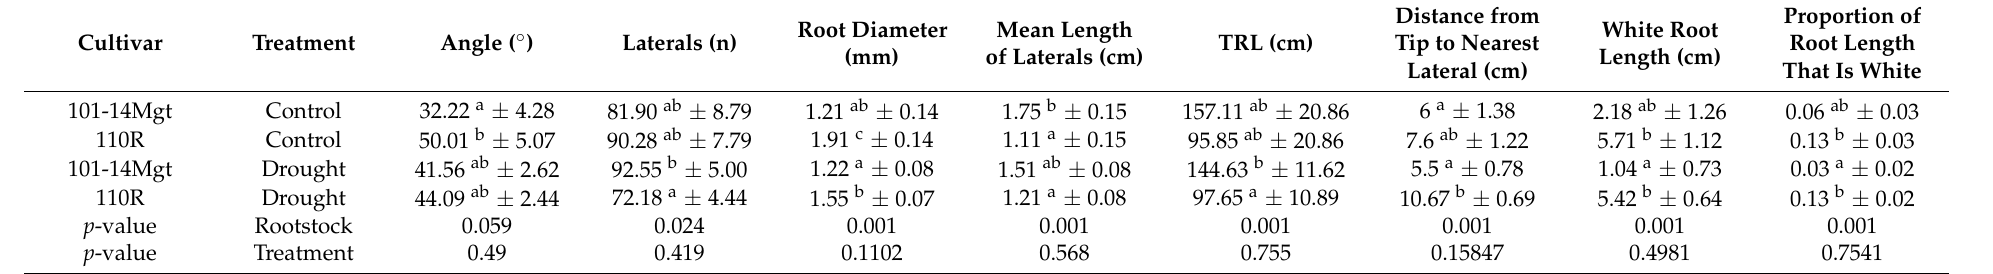
Table 2. Morphological root traits of 110R and 101-14Mgt rootstocks under well-watered (i.e., control) and drought conditions observed in the rhizotron